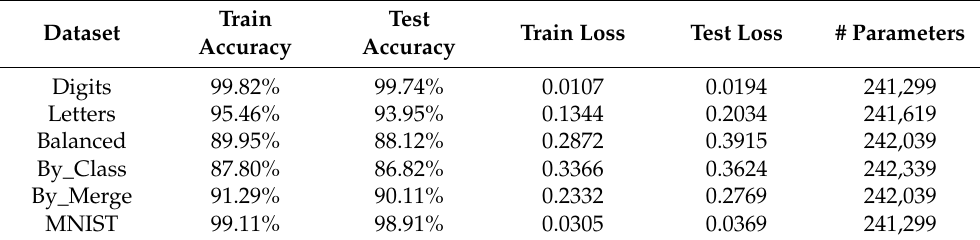
Figure 7. Training and test loss of the tuned architecture for each dataset. Table 4. Performance summary of each